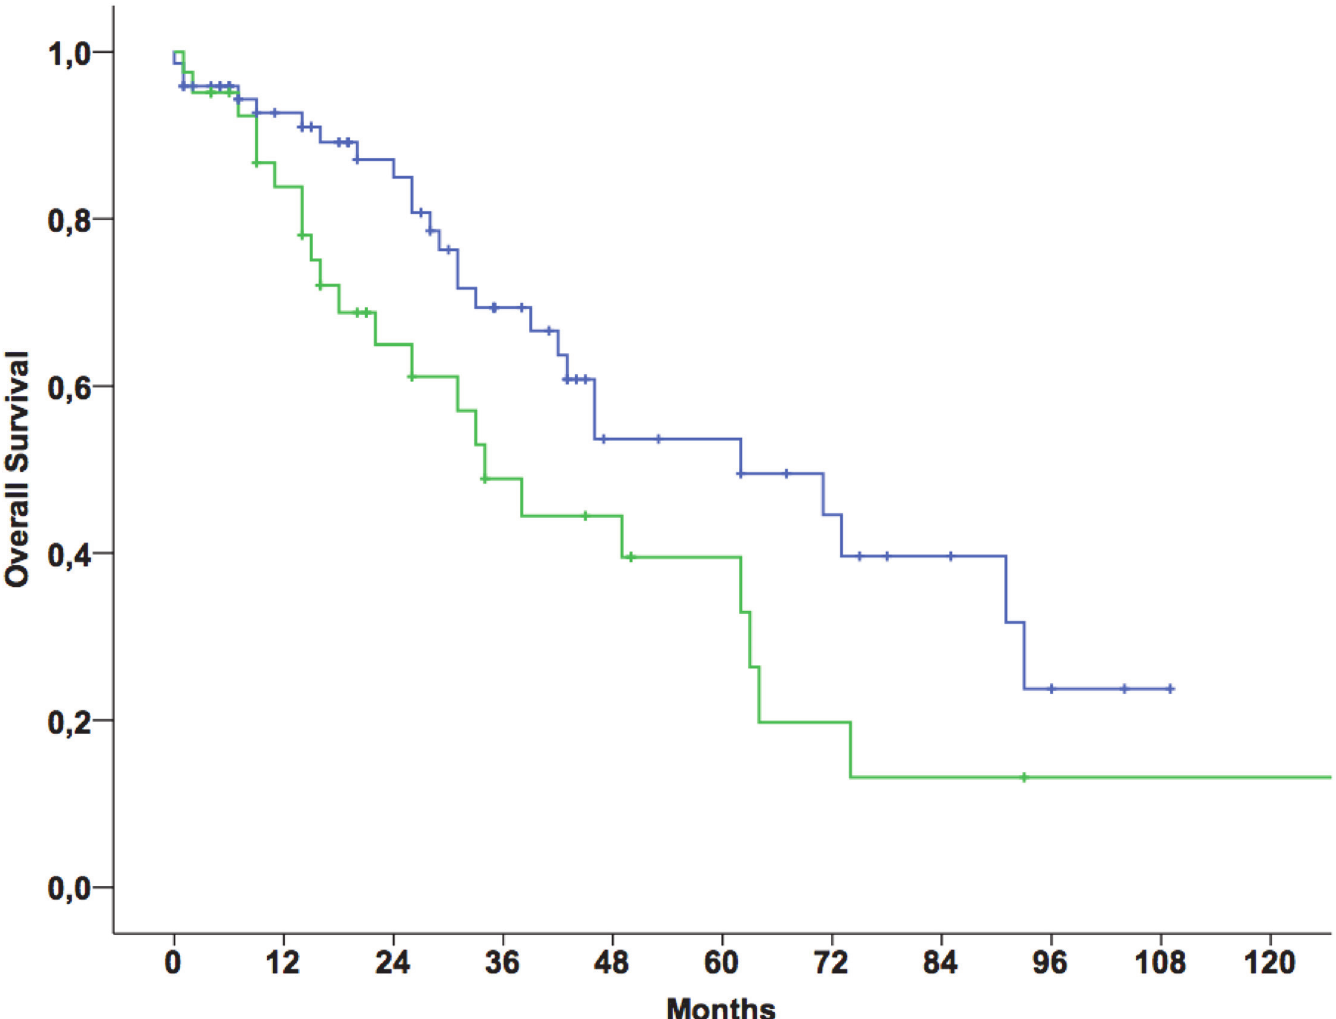
Fig 1. Kaplan-Meier curves for pre-therapeutic GGT levels groups A and B (n = 73, upper line) vs. C and D (n = 41, lower line) and overall survival ( P-value for log-rank test <